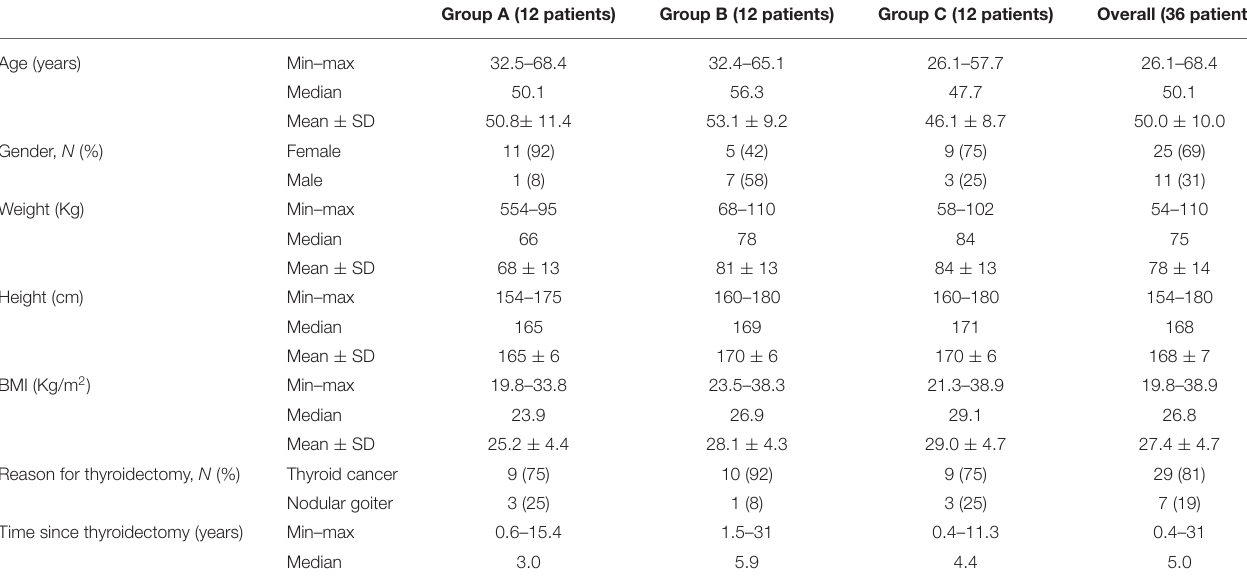
TABLE 1 | Patients’ characteristics at study